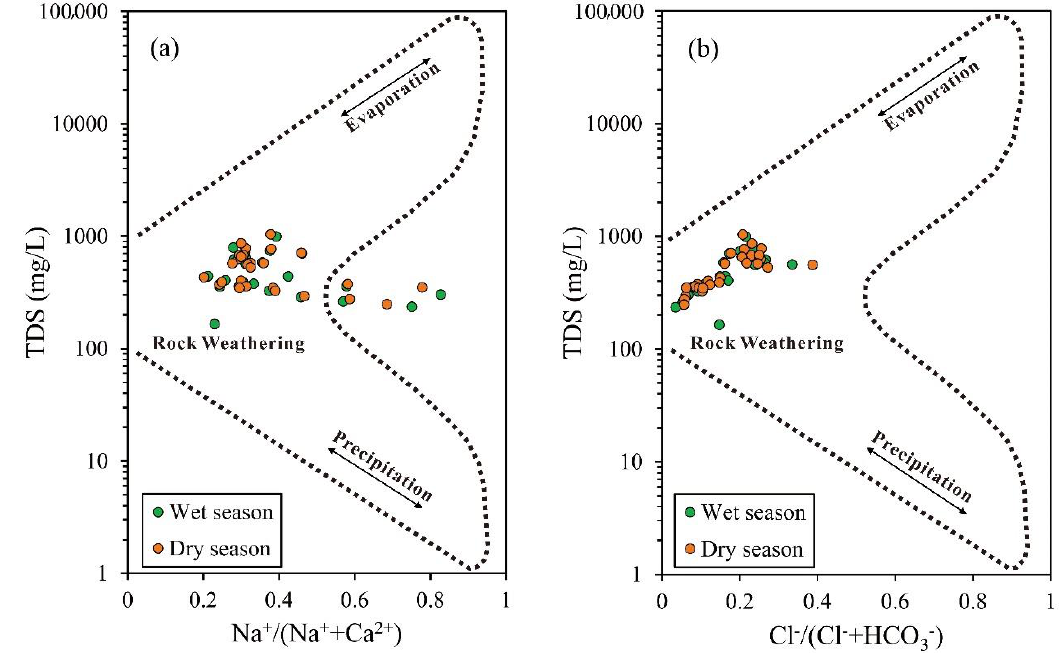
Figure 4. Gibbs analysis chart of groundwater quality in the study area. ( a ) [Na + /(Na + + Ca 2+ )] vs. TDS. ( b ) [Cl − /(Cl − + HCO − )] vs. TDS. 3